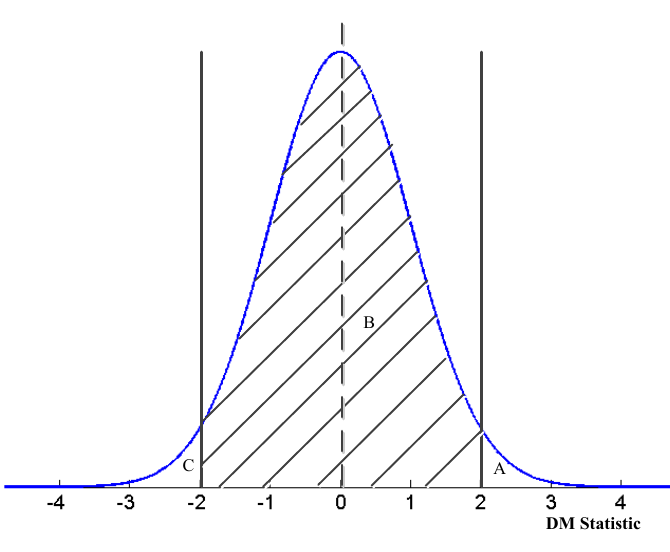
Figure 1. The normal